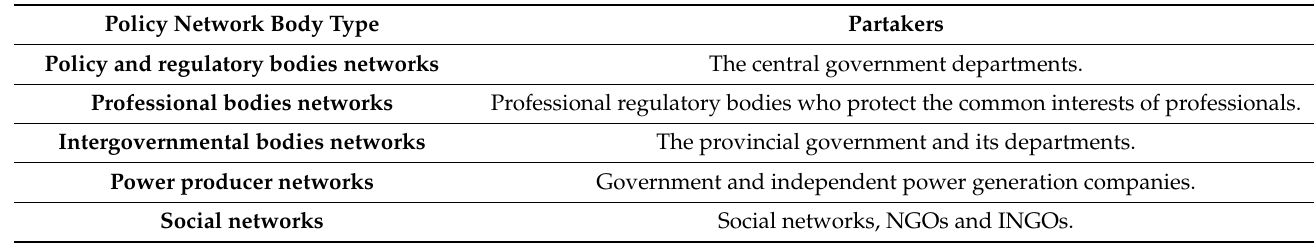
Table 5. Policy network theory model classification by